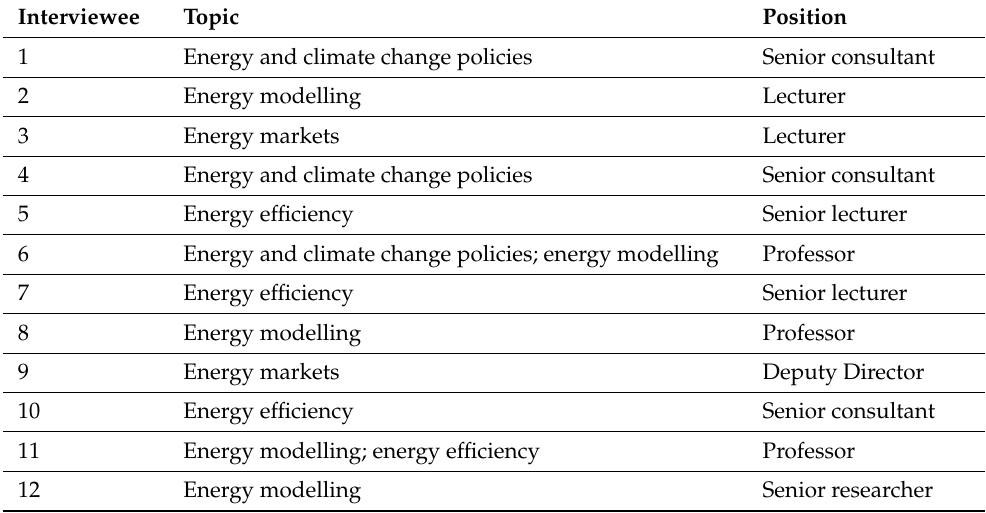
Table A3. Sample of